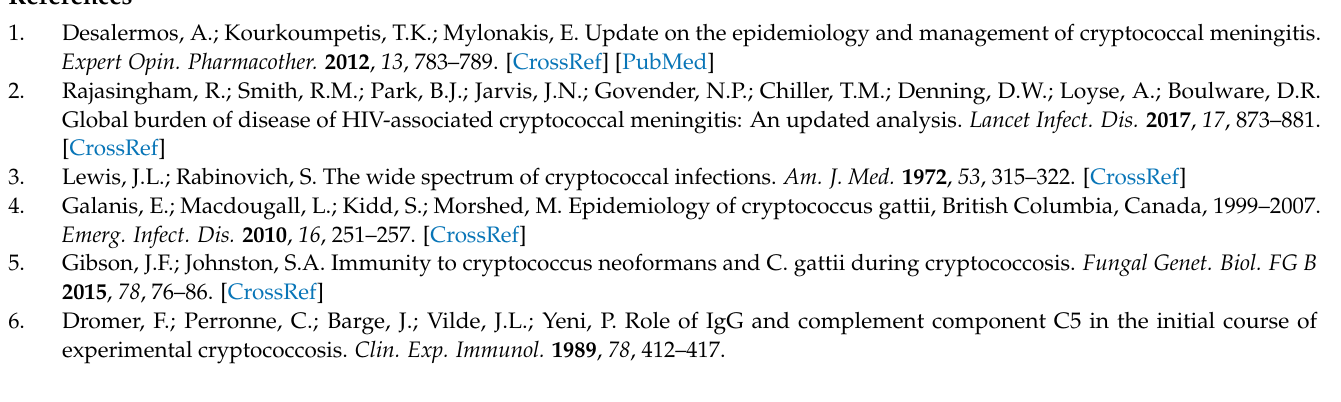
Table S2: Genes significantly expressed ( p < 0.05) in both PBMC ( Candida and Cryptococcus ) and Murine ( Cryptococcus )